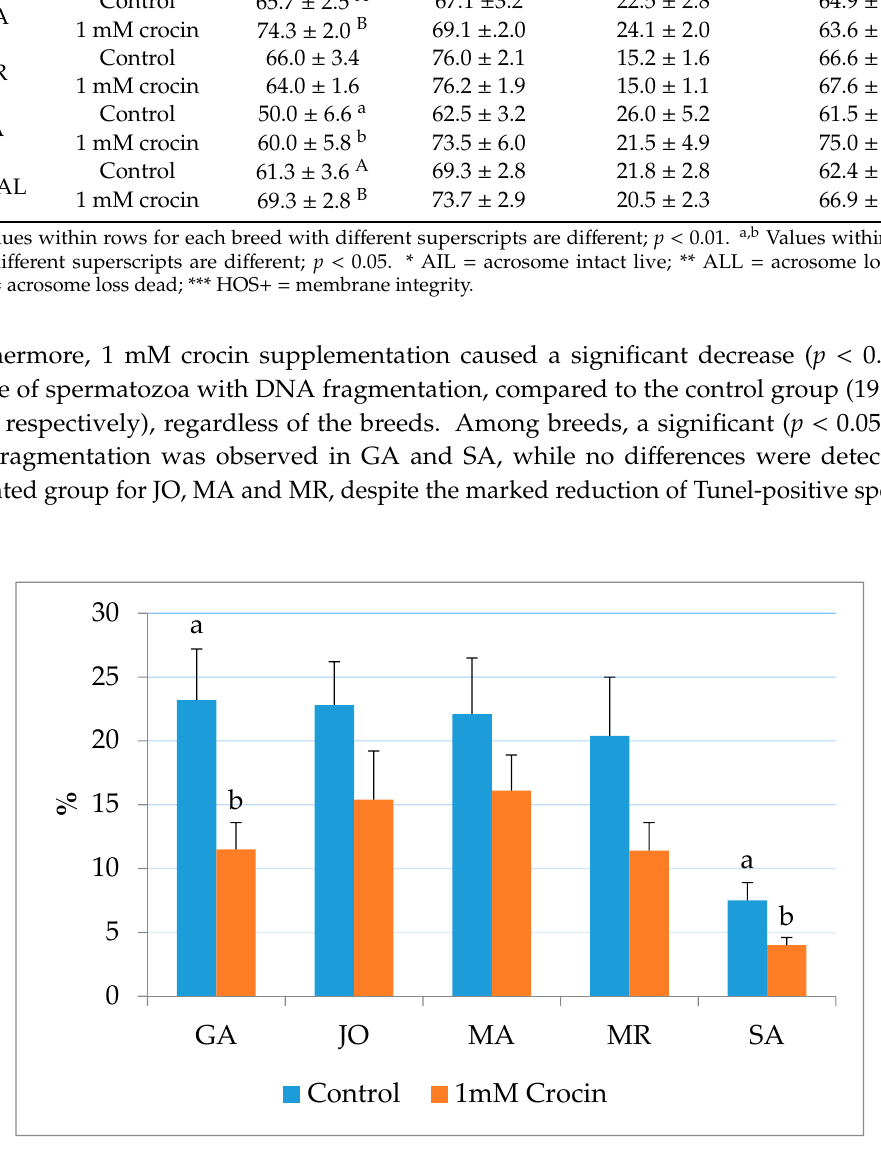
Table 4. Frozen–thawed semen qualitative characteristics between 0 mM (control) and 1 mM crocin groups in different breeds: Garganica (GA), Jonica (JO), Maltese (MA), Mediterranean Red (MR) and Saanen (SA). Data are expressed as mean ± SEM.